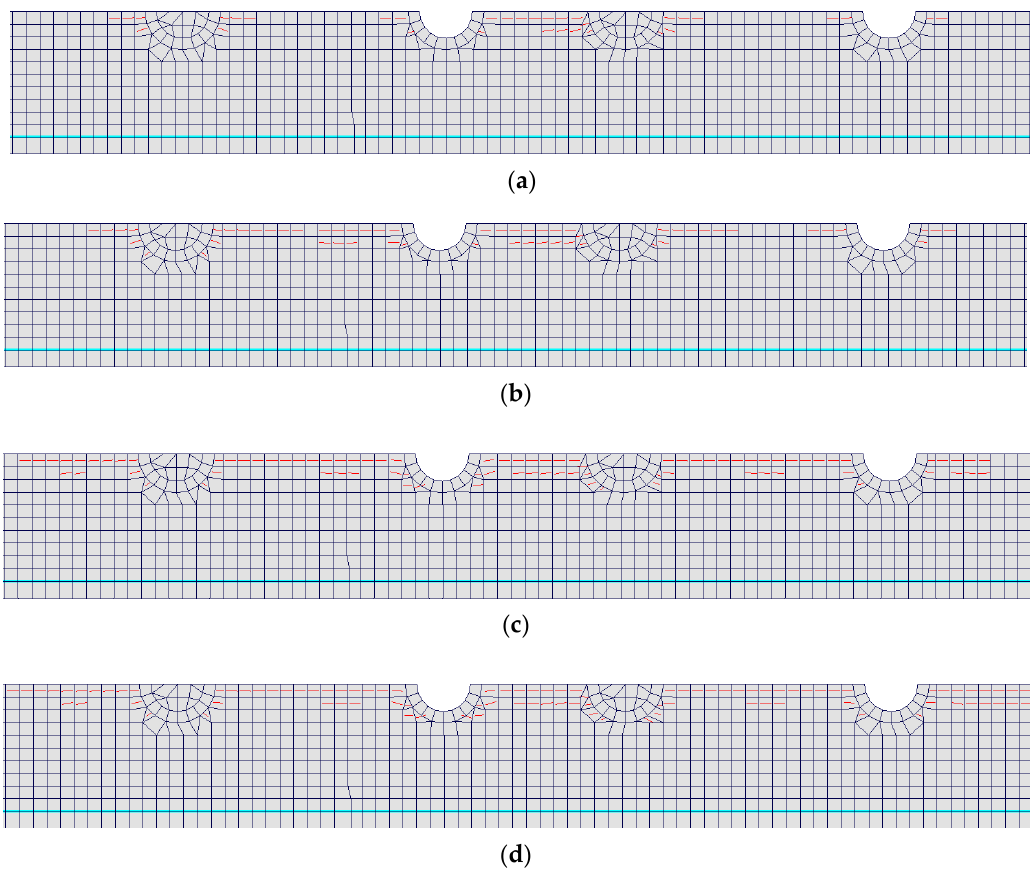
Figure 8. Samples of the cracking for D4 sleeper numerical model with carbonate aggregate at different temperature increments: ( a ) 18° C; ( b ) 24° C; ( c ) 30° C; ( d ) 36° C.